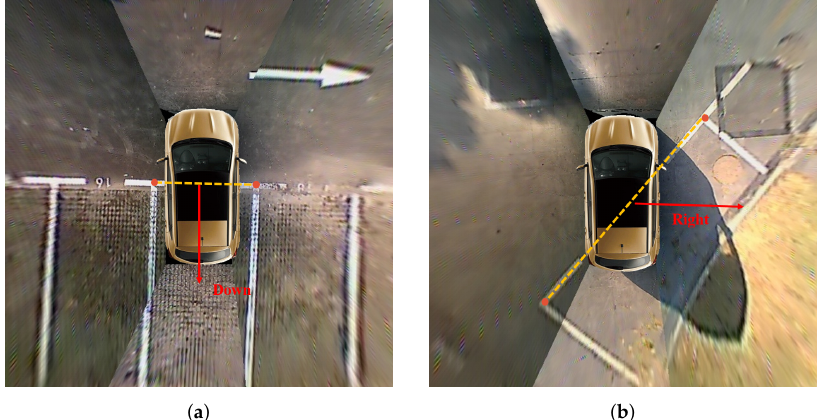
Figure 8. The orientation of the parking slot when the vehicle is parking into it. ( a ) shows the orientation of the vertical parking slot. ( b ) shows the orientation of the parallel parking slot. The red arrow indicates the orientation of the parking slot. The yellow dotted line indicates the entrance line.